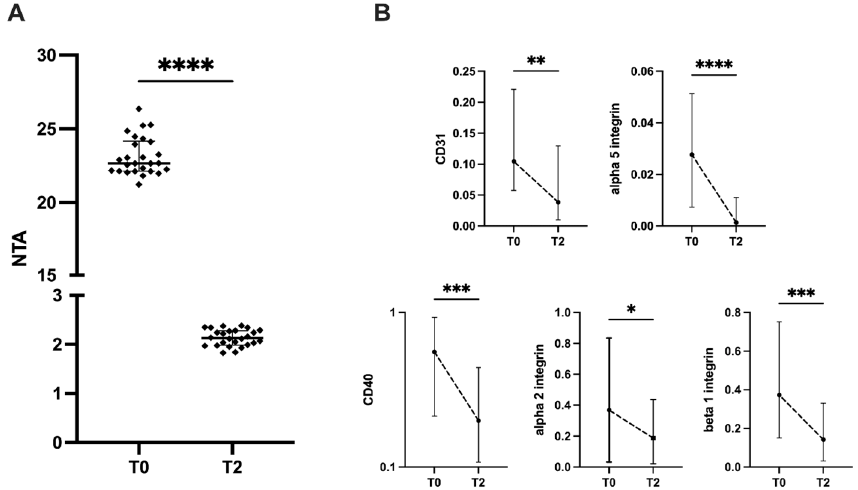
Figure 6. ( A ) Nanosight analysis of plasma EV concentration before (T0) and after KT (T2); ( B ) flow cytometry analysis of the surface protein expression of CD31, alpha 5 integrin, CD40, alpha 2, and beta 1 integrins. Results are presented as the median and IQR. Differences between the baseline (T0) and two years post-KT (T2) were analyzed using the Wilcoxon paired test. * p < 0.05, ** p < 0.01, *** p < 0.001, **** p < 0.0001 . Abbreviations: NTA—nanoparticle tracking analysis; CD—cluster of dif- ferentiation.